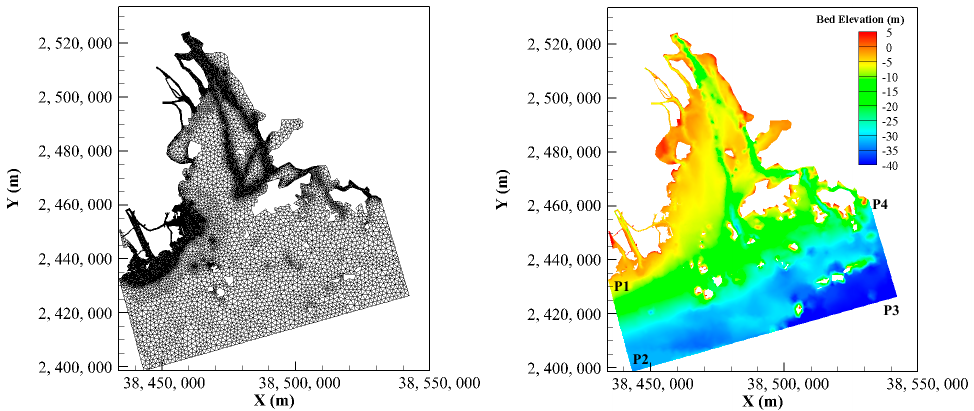
Figure 3. Computational grids, topography, and the tidal level boundaries of the study area.